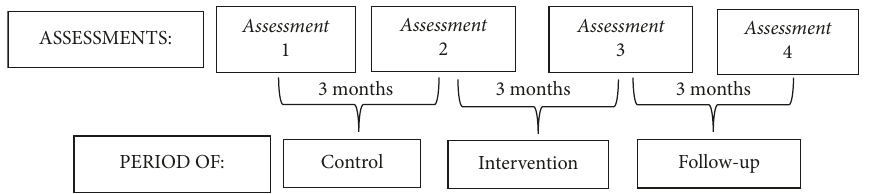
Figure 1: Outline of assessments and